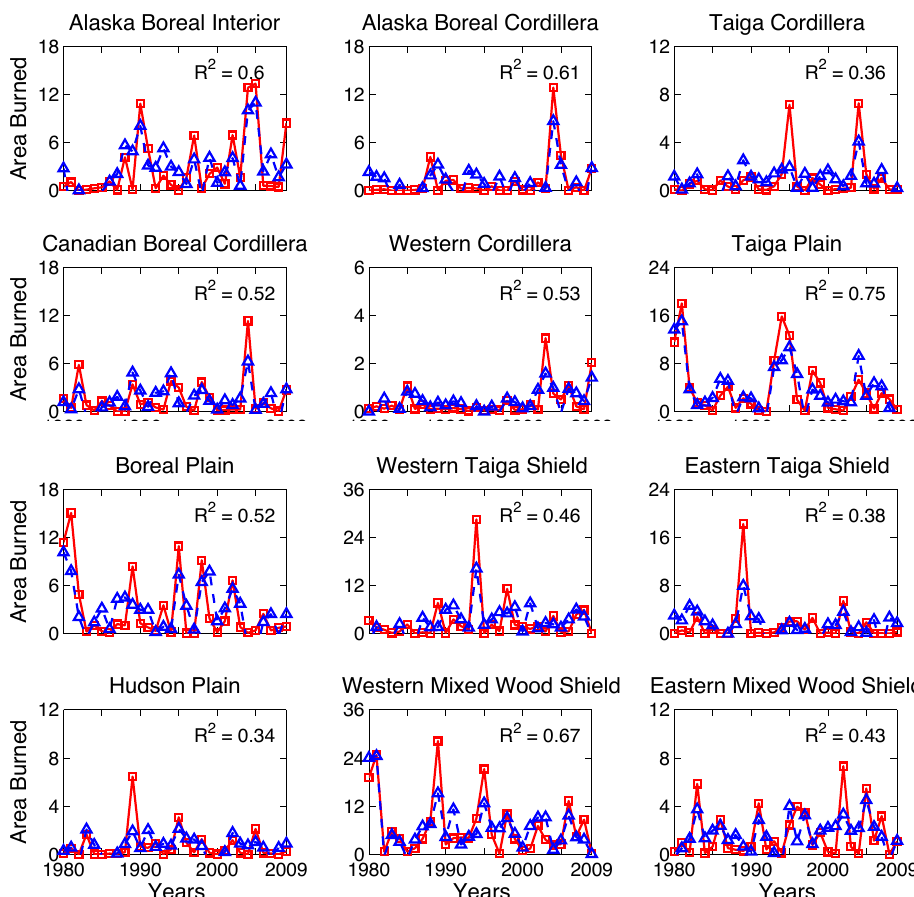
Figure 4. Observed (red solid lines) and predicted (blue dashed lines) area burned (10 5 ha) for 1980–2009 in boreal ecoregions. The area burned is calculated using the regressions for the fire season (May–October) for each ecoregion. Site-based meteorological observations from GSOD are used in the prediction. The fraction of the variance in observed area burned explained by the regression ( R 2 ) is shown on each panel.